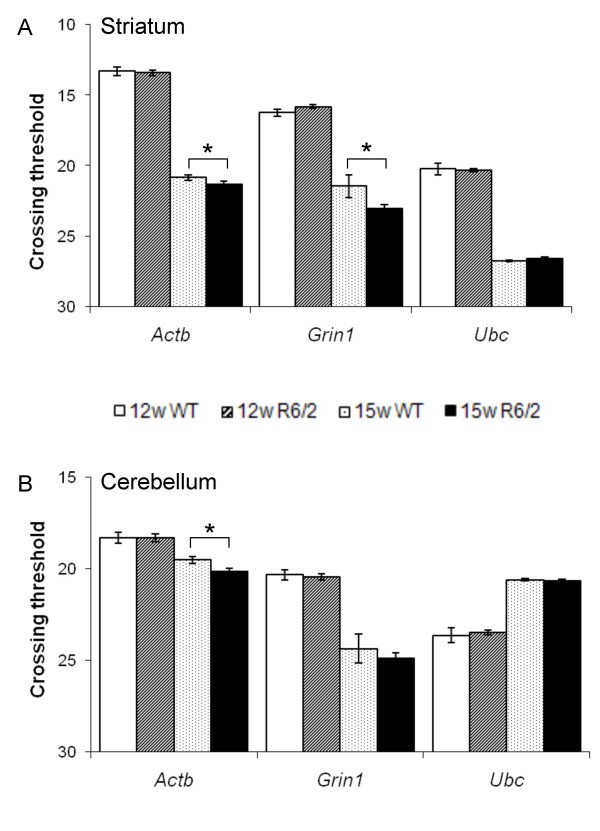
Progressive gene dysregulation in R6/2 mice over time. (A) Raw crossing threshold data for Actb, Grin1 and Ubc in 12 and 15 week old R6/2 transgenic mice and wild-type littermates in striatum shows an increase in crossing threshold data for both Actb and Grin1 but not Ubc, despite carefully controlling for RNA amounts. (B) Similar data as for (A), except that RNA extracts are from cerebellum. 12 week old wild-type (WT) = white bars, 12 week old R6/2 mice = stripes, 15 week old WT = dots, 15 week old R6/2 = solid fill bars. Error bars are S.E.M. (n = 10), * p < 0.05.